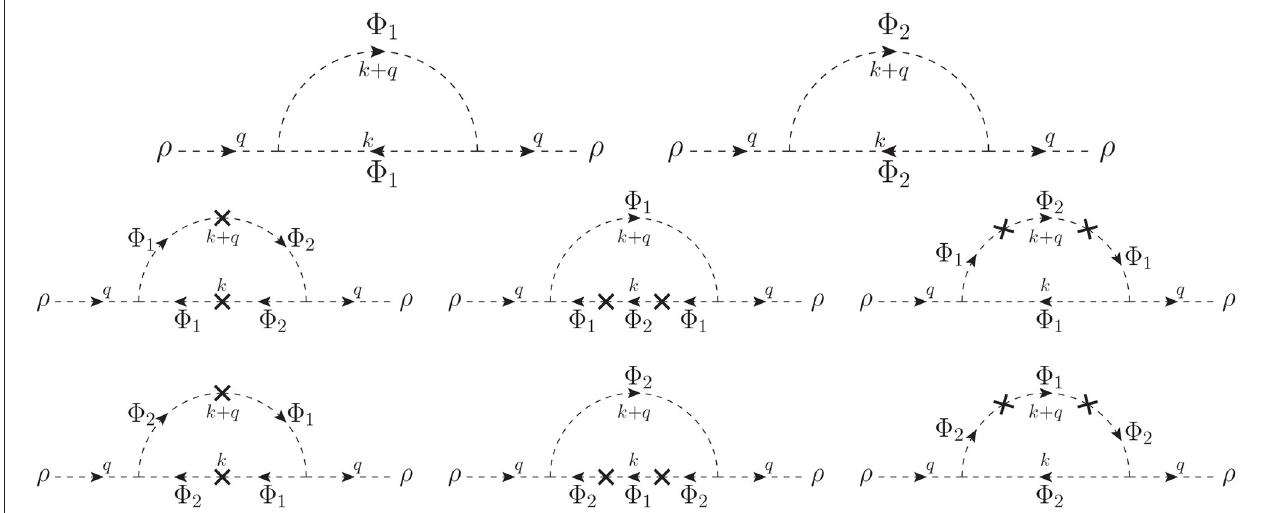
FIGURE 2 | One-loop contributions to the self-energy of the scalar ρ in the interaction basis. The first row corresponds to the LO in the MIA calculation (there is no mass insertion), while the second and third rows define the NLO (there are two mass insertions denoted by